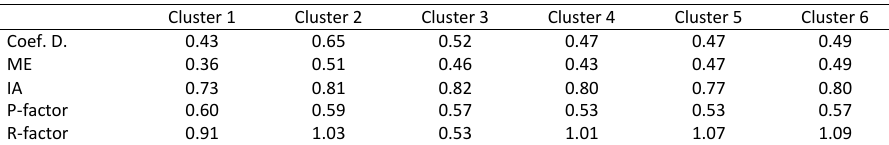
Fig. 4. Estimated vs. observed CO 2 efflux based on the time-dependent rating of specific-site production and transport approach (Eq. 4). (a): Scatter plot of simulated vs. measured CO 2 efflux for all clusters from 2006 to 2012, (b): Simulated vs. measured CO 2 efflux with associated 95 percent prediction uncertainty (95PPU) from 2011 to 2012 for the site M8 (cluster C2). C1… 6 means clusters 1… 6.